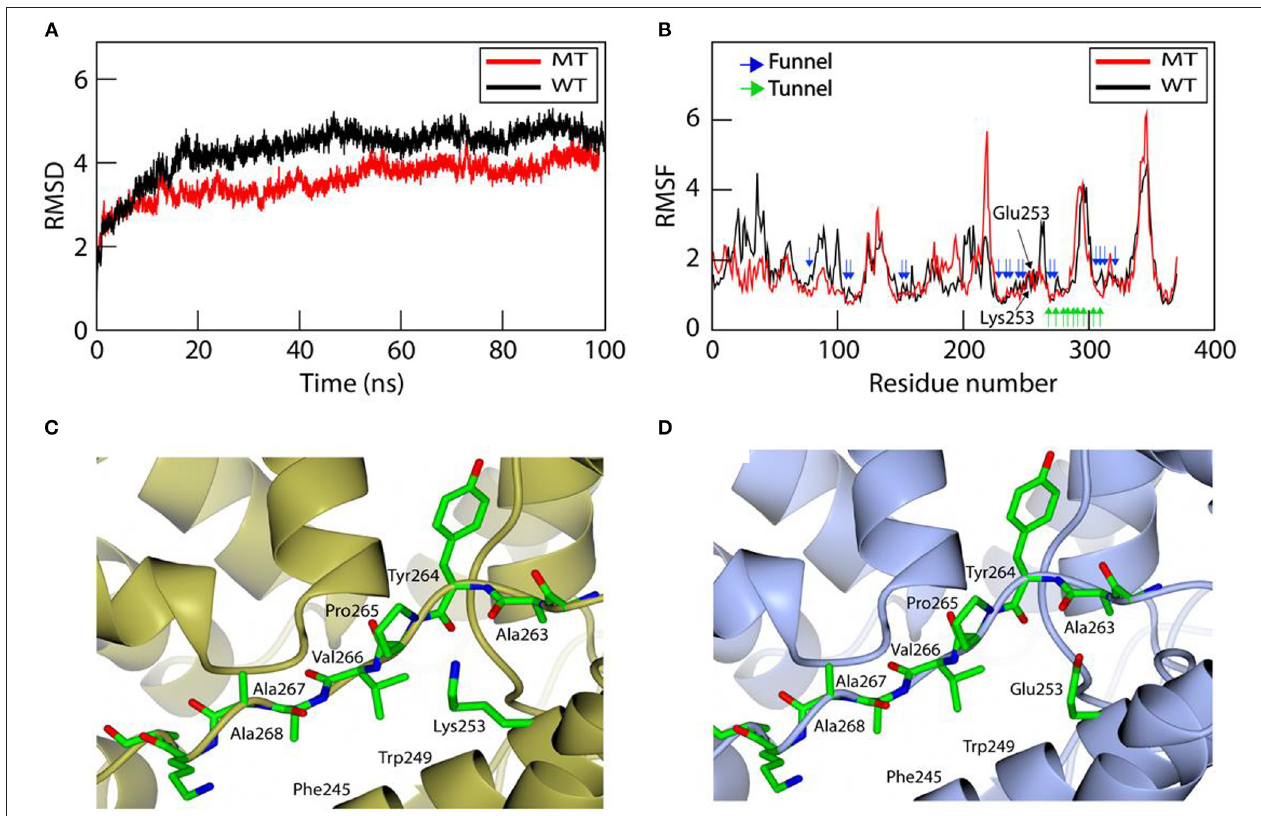
FIGURE 5 | Molecular dynamics simulation for investigating the structural stability and structural comparison of the wild-type and mutant MBOAT7 models. (A) Root mean square deviation (RMSD) of the wild-type and mutant MBOAT7 models during 100 ns molecular dynamics simulation. The initial structure was used as the reference point for RMSD calculations. (B) The per residue root mean square fluctuation (RMSF) is calculated for the wild-type and mutant MBOAT7 models. The funnel, tunnel, and mutation site are indicated using blue, green, and black arrows, respectively. (C) Mutant and (D) wild-type MBOAT7 near the mutation site is shown using ribbon and stick